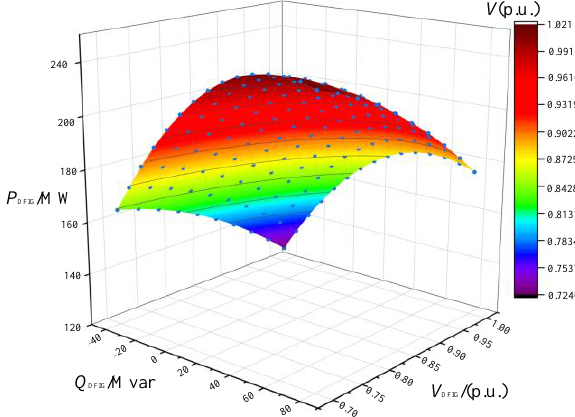
Figure 7. SSSR of G 89 synchronous unit.